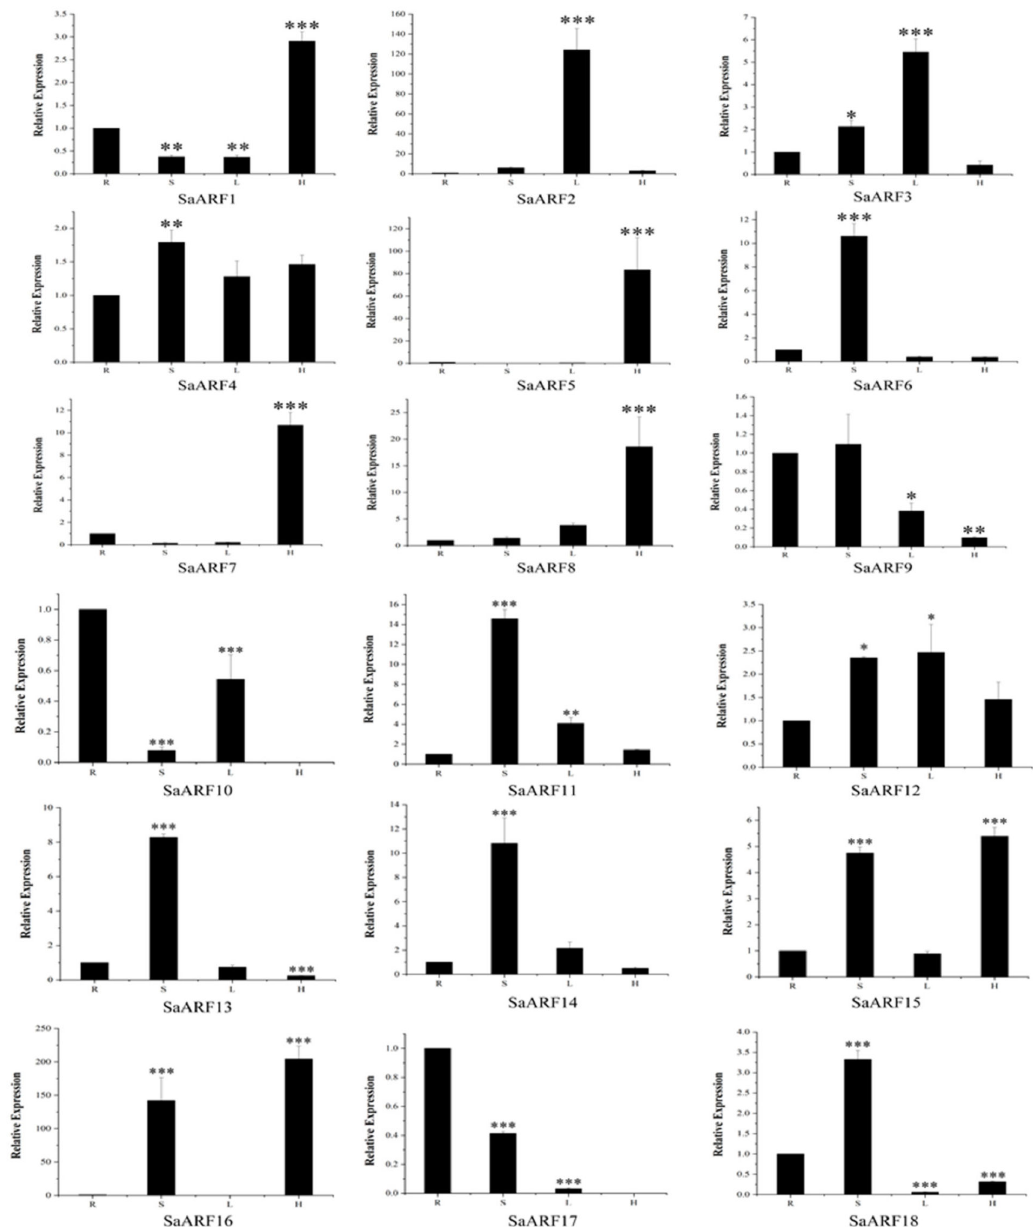
Figure 10. Expression analysis of 18 ARF genes in four representative tissues by qRT-PCR. Four various tissues include root, stem, leaf, and haustoria. The relative expression was calculated based on the 2 − ∆∆ Ct method. Error bars indicate ± standard deviation (SD) of three biological replicates. R: Root; S: Stem; L: Leave; H: Haustoria. Asterisks denote significant differences: * p < 0.05; ** p < 0.01; *** p <